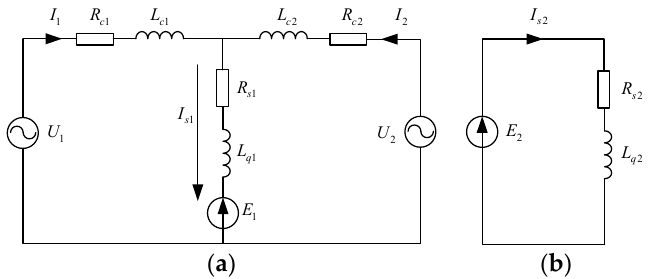
Figure 4. Single-phase equivalent circuit of the LLSM with three-phase short-circuit fault: ( a ) normal part; ( b ) fault part.